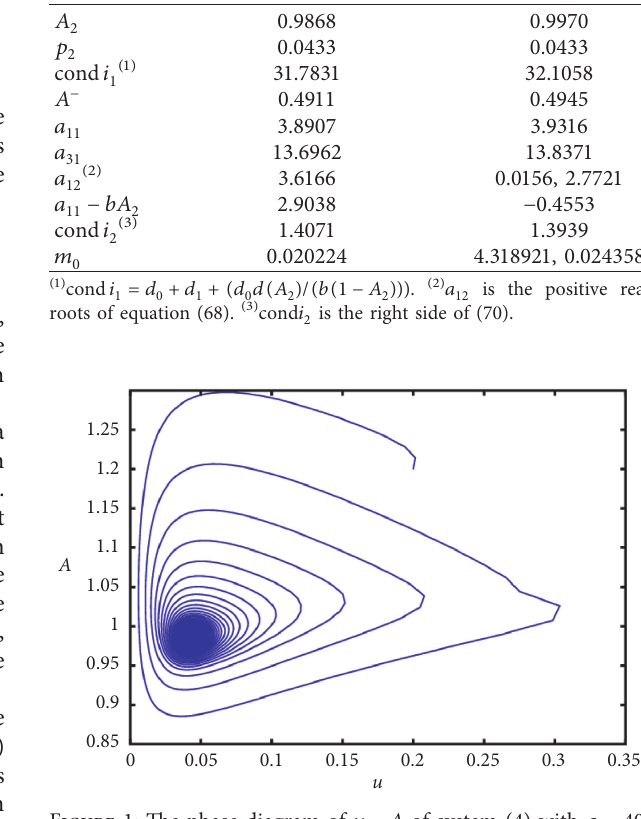
� 0 . 3, d � 0 . 2, d � 0 . 7 and 0 1 2